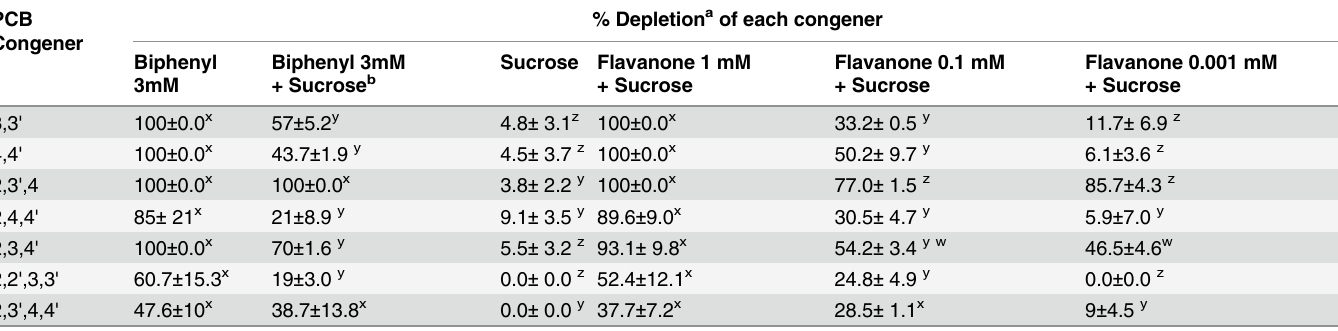
2,3,4' 100 ± 0.0 x 70 ± 1.6 y 5.5 ± 3.2 z 93.1 ± 9.8 x 2,2',3,3' 2,3',4,4' 9 ± 4.5 y a % depletion ± standard deviation, of each congener of a mix of 18 PCB congeners according to the protocol described in the Materials and Methods section. (Only the congeners that are degraded under at least one of the set conditions are listed). Different letters indicate signi fi cant differences according to Tukey ’ s test (P (cid:1) 0.05)